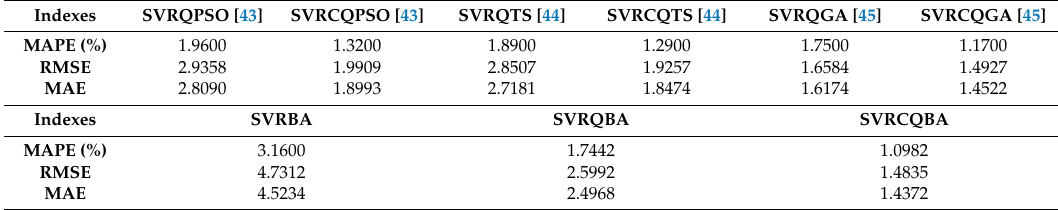
Figure 2. Forecasting values of SVRCQBA and other alternative compared models. Table 2. Forecasting indexes of SVRCQBA and other alternative compared